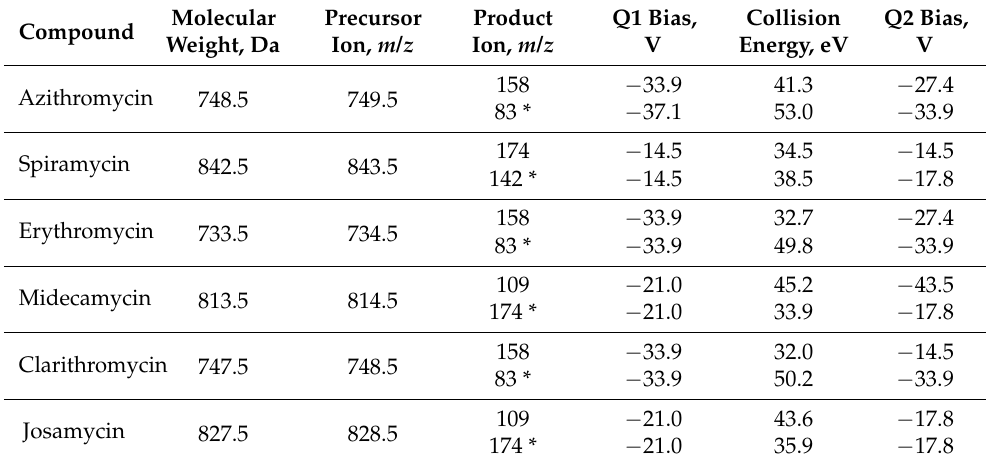
Table 1. Optimized conditions for mass spectrometric detection of six macrolide antibiotics in the MRM